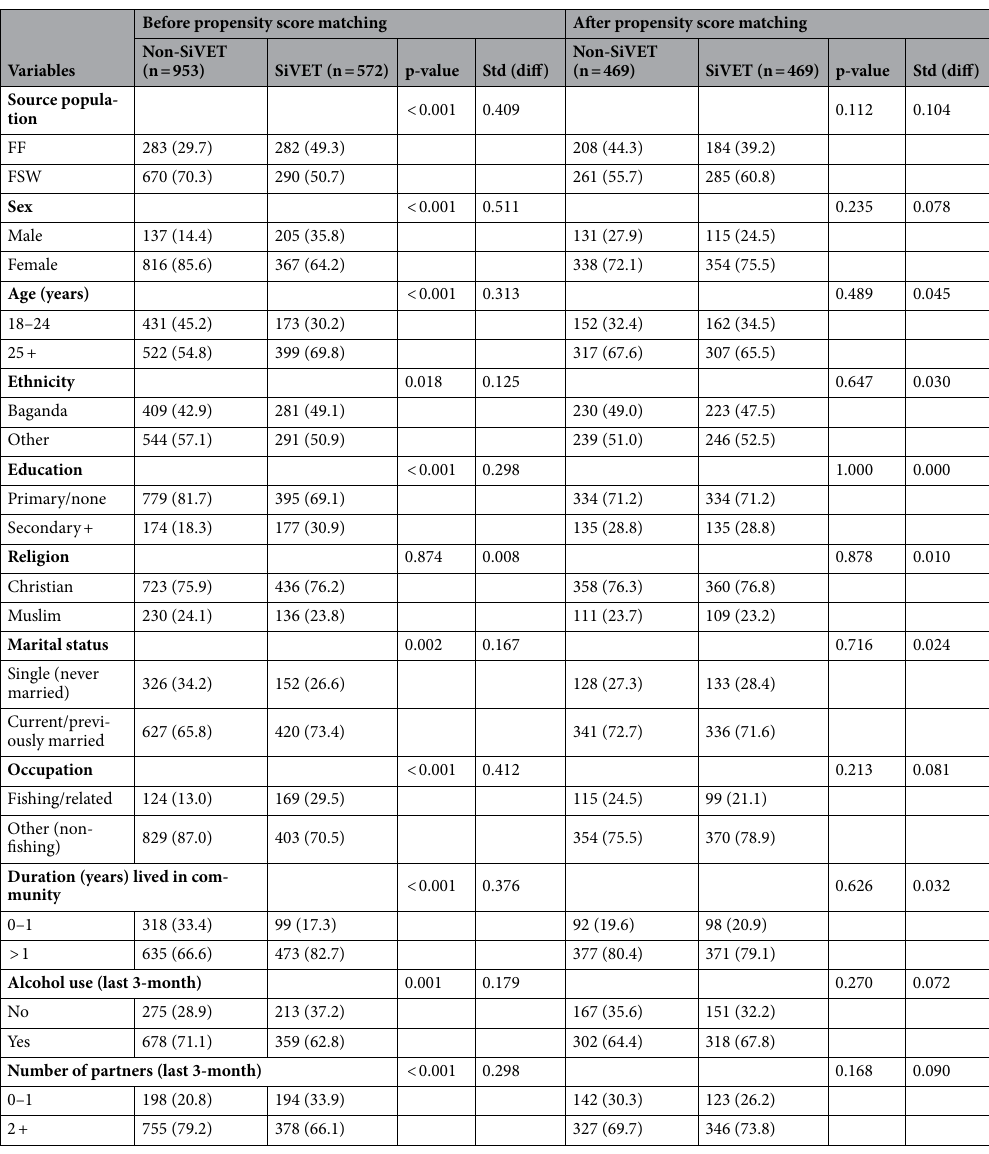
Table 2. Baseline characteristics and covariate balance (non-SiVET vs SiVET) in the concurrent period. SiVET simulated vaccine efficacy trial, Std (diff) standardized difference, FF fisherfolk, FSW female sex